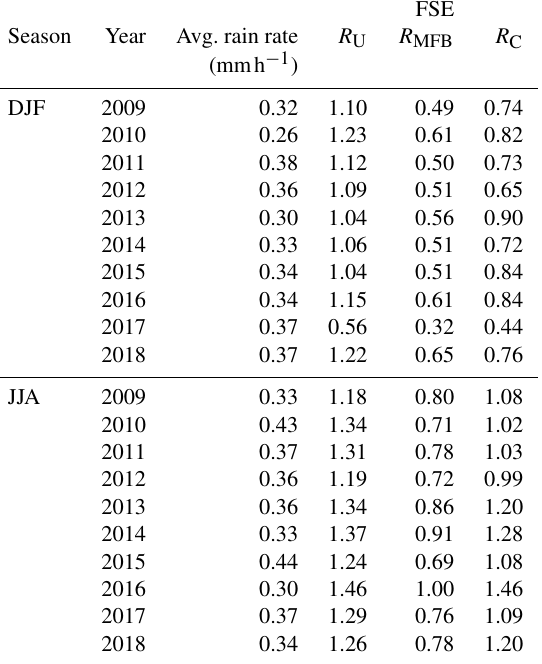
Table A1. Country-average fractional standard error (FSE) between the hourly reference rainfall ( R A ) and the three QPE products ( R U , R MFB and R C ) per year for the winter (DJF) and summer (JJA) sea- sons. The FSE was only calculated for hours in which the country- average rainfall rate was larger than 0.0mmh − 1